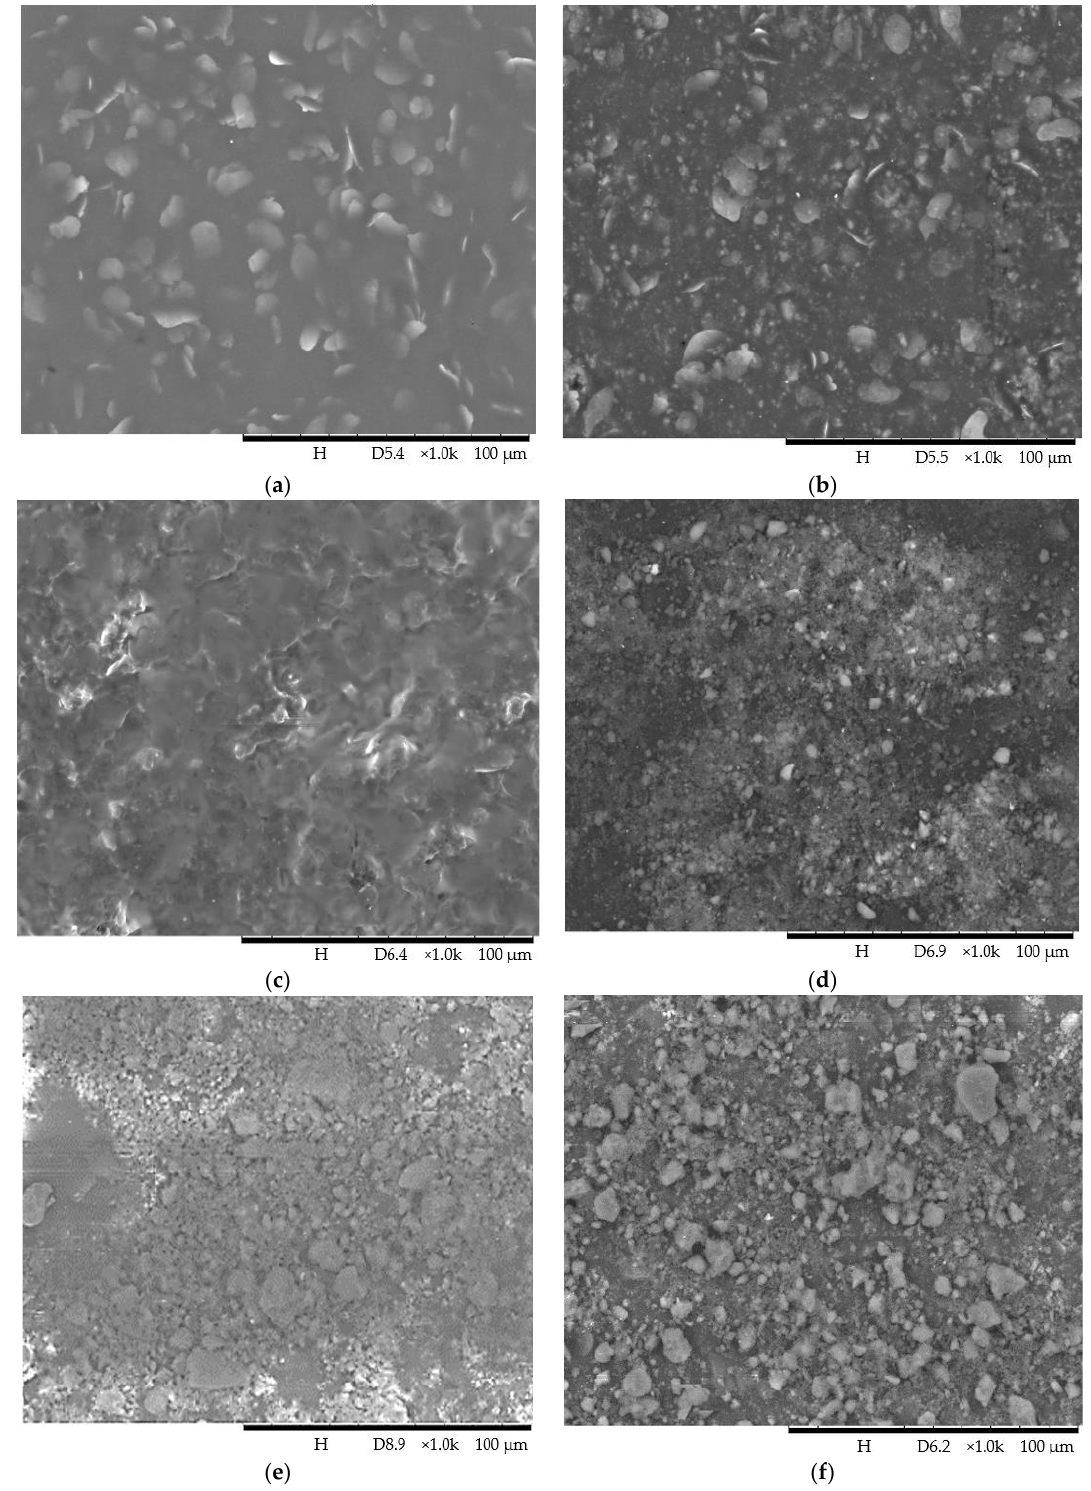
Figure 4. SEM images of ( a ) PU coating (R-0), ( b ) PU coating blended with silica nanoparticles (N/7.0), ( c ) silane modified PU coating blended with silica nanoparticles (S/7.0), dual-layer coating with PU and 1.0 wt.% of silica nanoparticles in ( d ) ethanol (E/1.0), ( e ) THF (T/1.0) and ( f ) paint thinner (P/1.0).